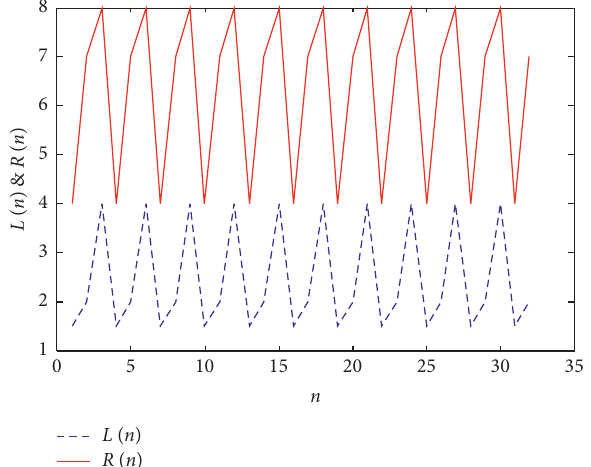
Figure 1: The solution of system (85) when α � 0.